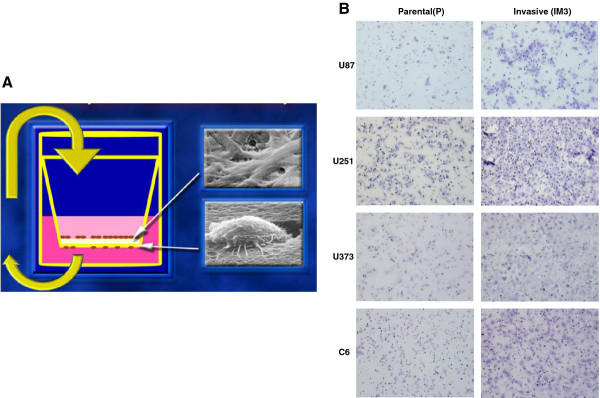
Selection of highly invasive glioblastoma cell line subpopulations (IM3). (A) Schematic diagram of our serial selection algorithm (Matrigel Invasion Chamber, BD Bioscience). (B) Serial selection of cells resulted in highly invasive subpopulations of each cell type. Cells (P, parental cells) were invaded through 8 μm Matrigel® pores three times for selection of invasive cells (IM3).